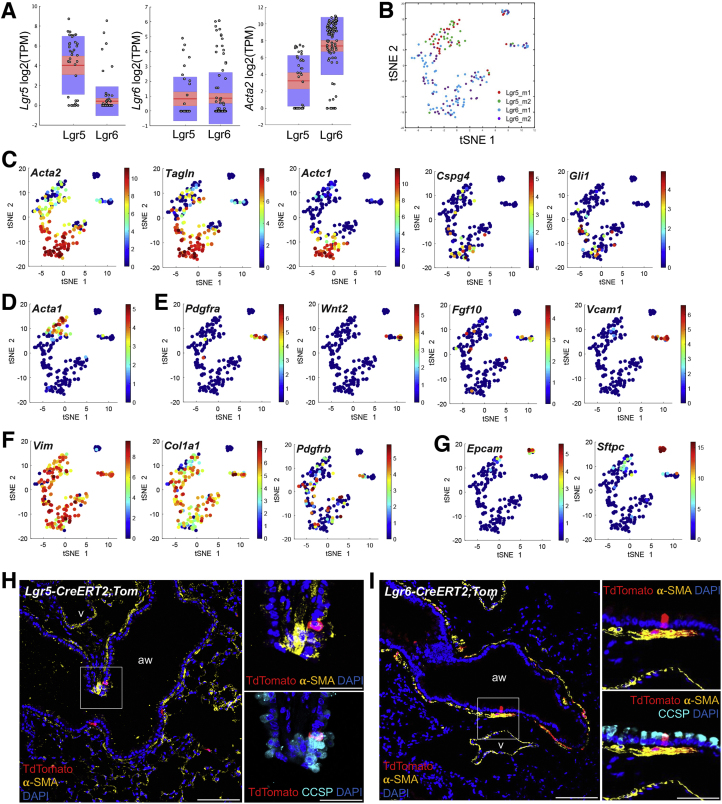
Heterogeneity of Lgr5- and Lgr6-Expressing Cells, Related to Figure 2(A) Expression of Lgr5, Lgr6, and Acta2 in individual cells analyzed by single cell RNA-seq. Shown are boxplots of the distribution of expression levels (log2(TPM+1)) for Lgr5 (left panel), Lgr6 (middle panel), and Acta2 (right panel) in Lgr5+ (left bar) and Lgr6+ (right bar) cells (x axis).(B) T-Stochastic neighbor embedding (tSNE) plot of 182 individual Lgr5+ (red and green, two replicates) and Lgr6+ (blue and purple, two replicates) cells, after quality filtering.(C–G) tSNE plots as in (B) but where cells are colored by the expression of specific genes, as marked.(H and I) Representative confocal images showing expression of Lgr5 and Lgr6 in airway epithelial cells in adult distal lungs: Tdtomato (for Lgr5 or Lgr6, red), CCSP (cyan), and DAPI (blue) in lung tissue sections from Lgr5-CreERT2;R26-Tom (H) and Lgr6-CreERT2;R26-Tom (I) mice, following by Tamoxifen injection (Tmx, 0.2mg/g x 4). Scale bars, low magnification 200um; high magnification 50um.